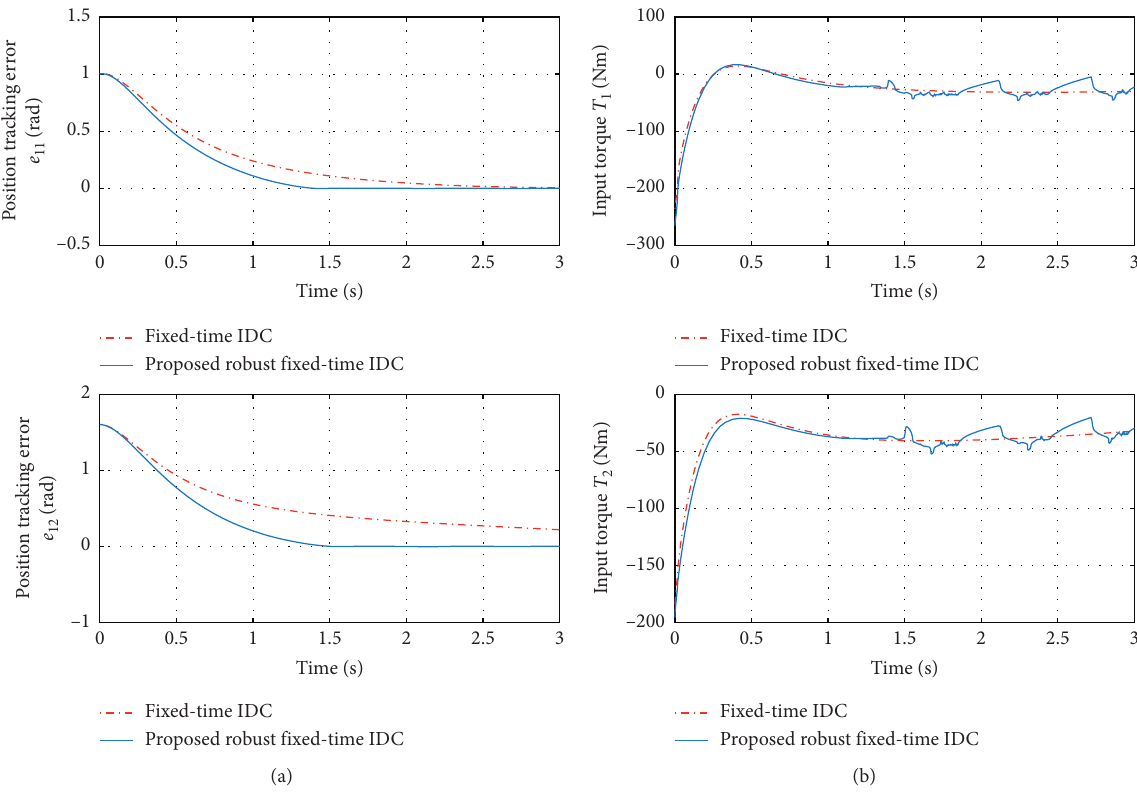
Figure 3: Responses in case 2. (a) Position tracking errors. (b) Input torques.